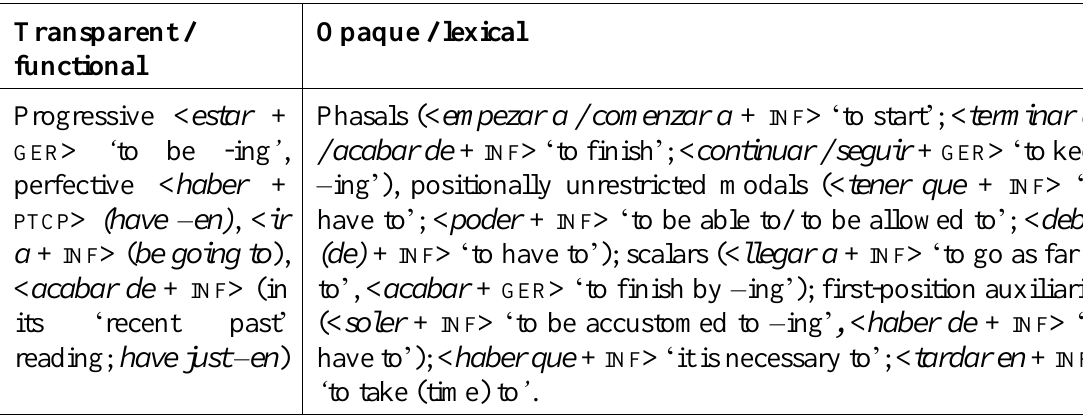
Table 1. Lexical and functional